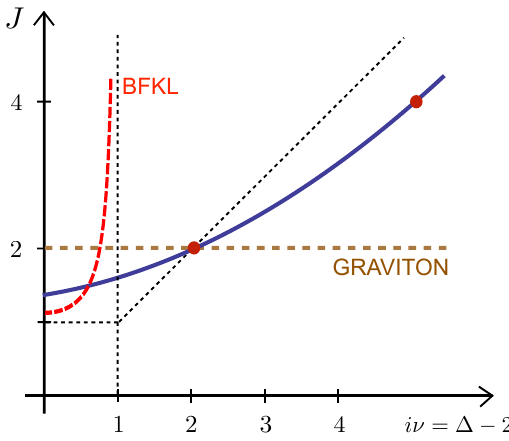
Figure 5 . Expected form of the (cid:1) = (cid:1)( J ) curve (in blue). Free theory is the oblique dashed line. At in(cid:12)nite coupling the curve degenerates to the graviton horizontal line (in brown). Resuming perturbation theory one obtains, away of the spectral region, the BFKL curve (in red). For the gravitational theory with action (4.4), the TT metric (cid:13)uctuations around a background of the form (3.8) are given